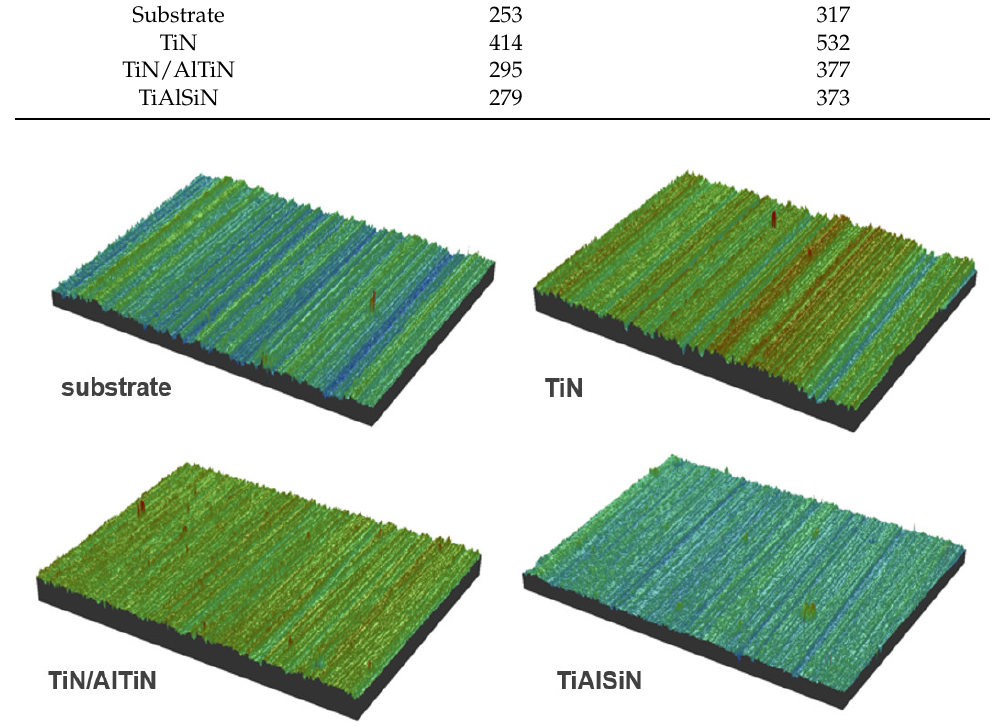
Figure 7. Three-dimensional surface topographies of bare cemented carbide substrate and the same substrate after deposition of TiN, TiN/AlTiN and TiAlSiN coatings. Table 2. Surface roughness parameters of substrate, TiN, TiN/AlTiN and TiAlSiN coatings.